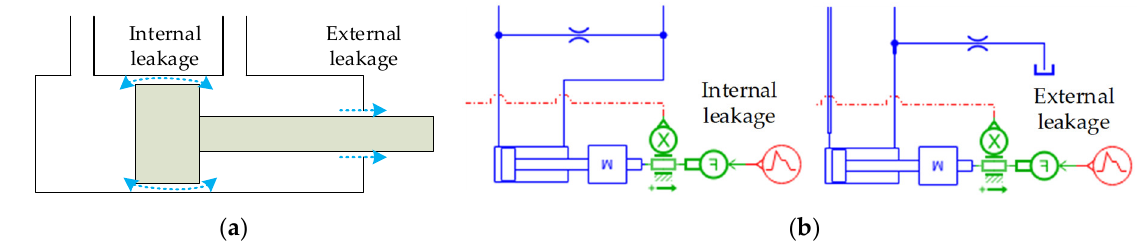
Figure 11. Actuator leakage principle: ( a ) Basic principles; ( b ) Simulation principle.